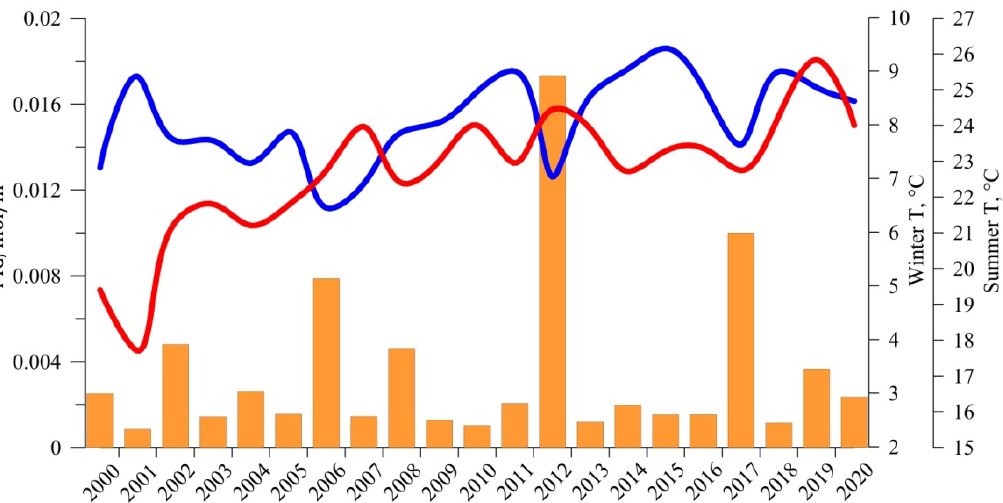
Figure 5. Dynamics of summer coccolithophore blooms (Average PIC values for June), minimum winter temperatures (February average)—blue line and summer temperatures (June average)—red line in the eastern Black Sea according to SeaWiFS and MODIS-Aqua.